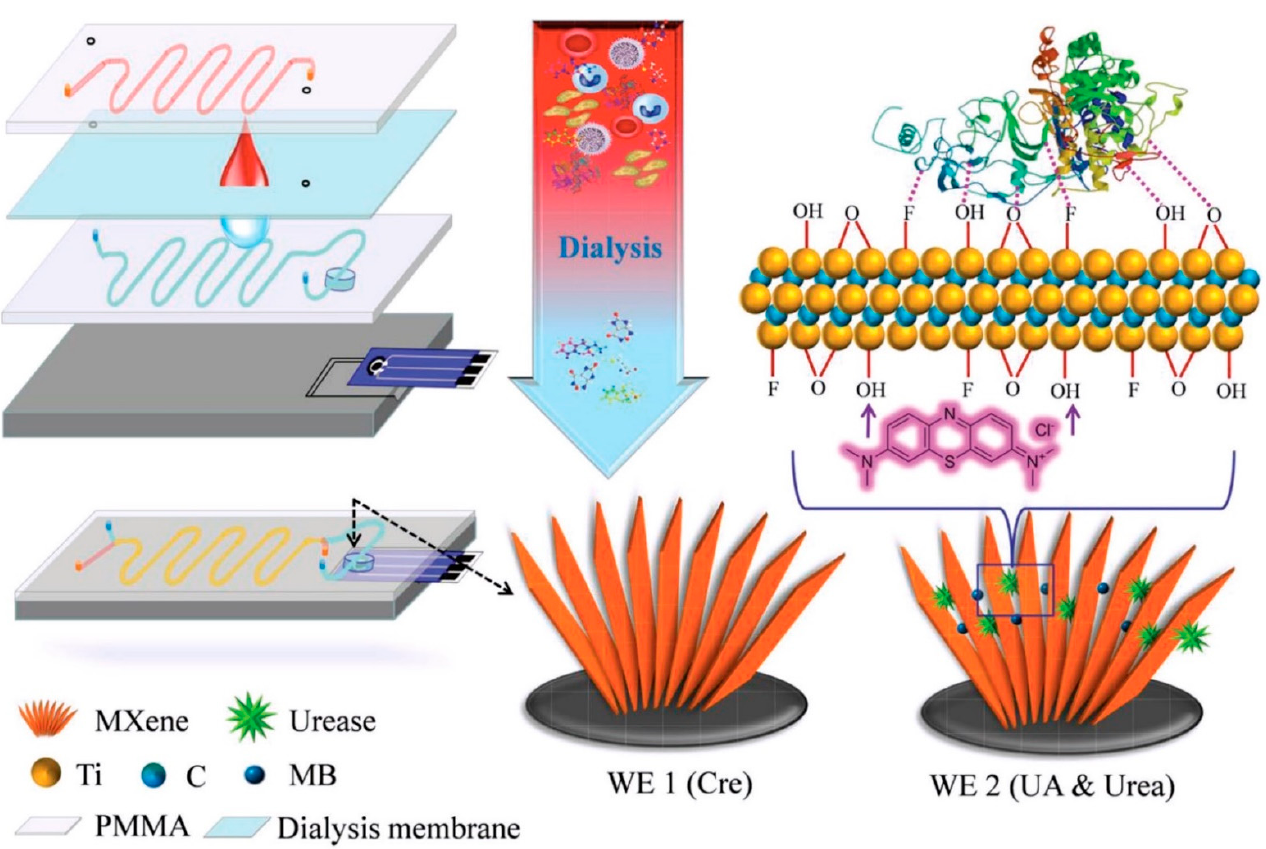
Figure 11. Structure of a microfluidic system with MXenes/MB/urea SPE for whole blood detection. Reprinted with permission from reference [178]. Copyright 2019 John Wiley and Sons.